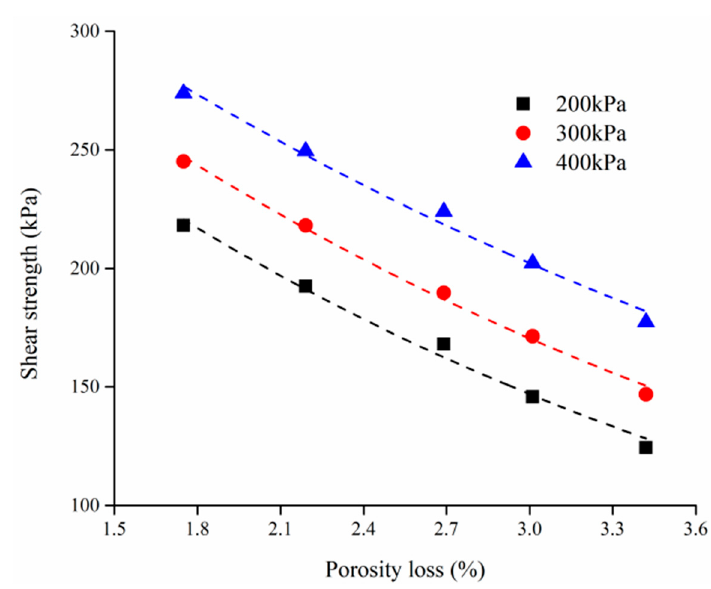
Figure 14. The relationship between shear strength and porosity change.